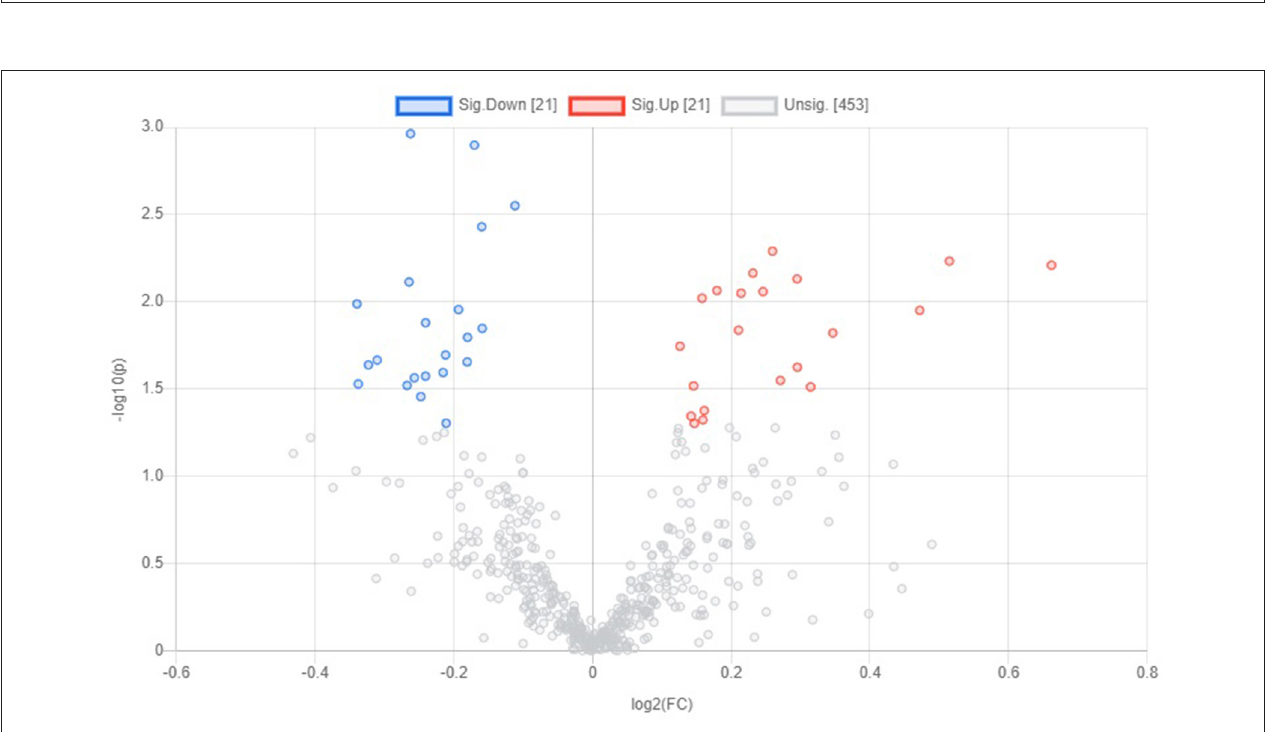
FIGURE 2 | Volcano plot showing the differentially abundant amine/phenol-containing metabolites. Metabolites with false discovery ratio ≤ 0.05 (red or blue) are differentially increased or reduced in HFE, relative to LFE. HFE, beef steers with negative residual feed intake; LFE, beef steers with positive residual feed intake.